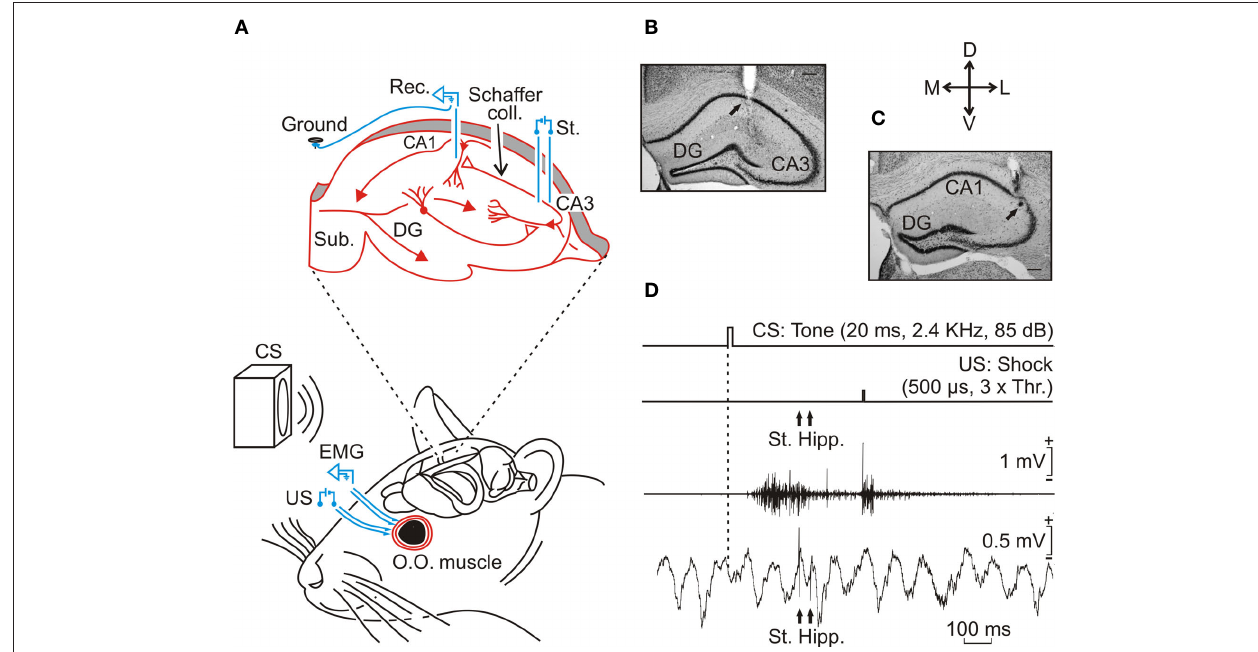
FIGURE 1 | Experimental design. (A) Animals were implanted with EMG recording electrodes in the orbicularis oculi (O.O.) muscle of the upper eyelid and with stimulating electrodes on the supraorbital nerve. The latter was used for presentation of unconditioned stimulus (US). For classical eyeblink conditioning, we used a tone (20 ms, 2.4 kHz, 85 dB) as a conditioned stimulus (CS). The loudspeaker was located 30 cm in front of the animal’s head. Animals were also implanted with stimulating (St.) electrodes at the Schaffer collaterals (coll.) and with a recording (Rec.) electrode in the CA1 area (see inset at the